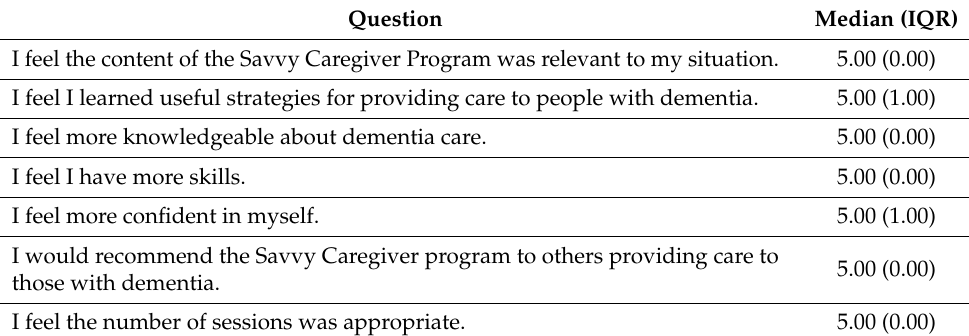
Table 4. Satisfaction and Feasibility of the Savvy Program ( n =